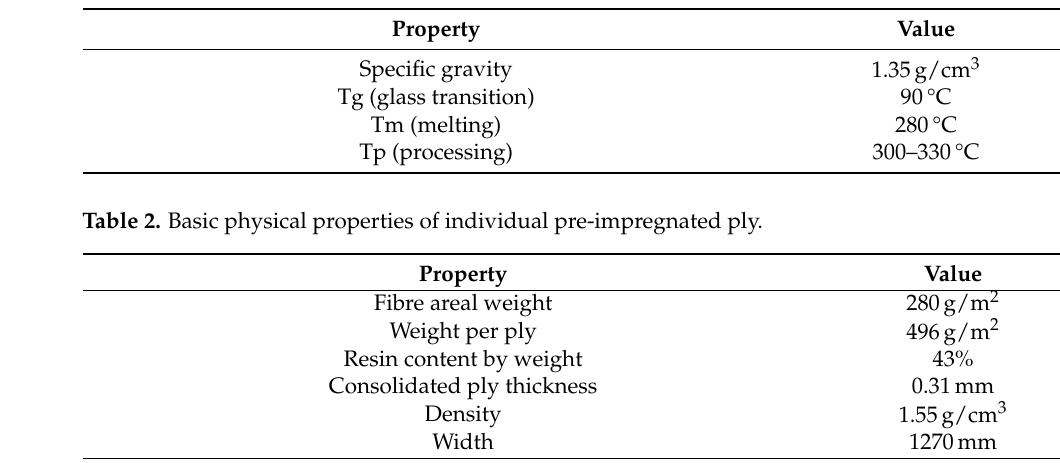
Table 1. Basic physical properties of neat resin.